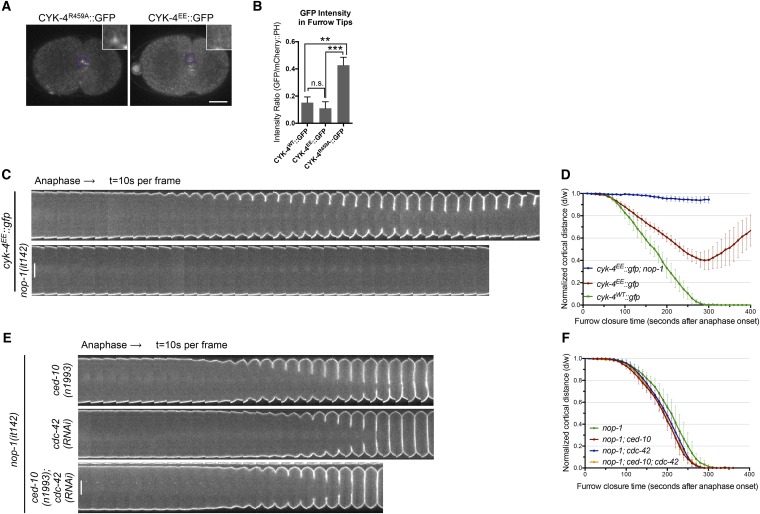
RhoA binding by CYK-4 is required for cytokinesis.(A) CYK-4R459A, but not CYK-4EE, hyperaccumulates on the plasma membrane of the ingressing cleavage furrows (boxed regions). (B) Membrane accumulation of CYK-4::GFP variants was quantified as described in Figure 1B. (N = 8–12 embryos; **p < 0.01, by one way ANOVA followed by Tukey multiple comparison). (C) The Rho family GTPase binding defective variant of CYK-4, CYK-4EE, , causes cytokinesis defects. Kymograph analysis of the progression of cytokinesis in CYK-4EE embryos in the presence or absence of NOP-1 function. Kymographs were assembled as described in legend to Figure 1D. (D) The kinetics of furrow ingression in CYK-4EE embryos. Results are quantified as described in Figure 1G. (E) Inactivation of CDC-42 and CED-10/Rac1, either alone or in combination, does not cause cytokinesis defects in the sensitized nop-1 background. Kymographs were assembled as described in legend to Figure 1D. Note that depletion of CDC-42 results in symmetric cleavage furrow ingression. (F) The kinetics of furrow ingression in embryos deficient in nop-1 and/or CDC-42 and/or CED-10/Rac1 function. Results are quantified as described in Figure 1G.